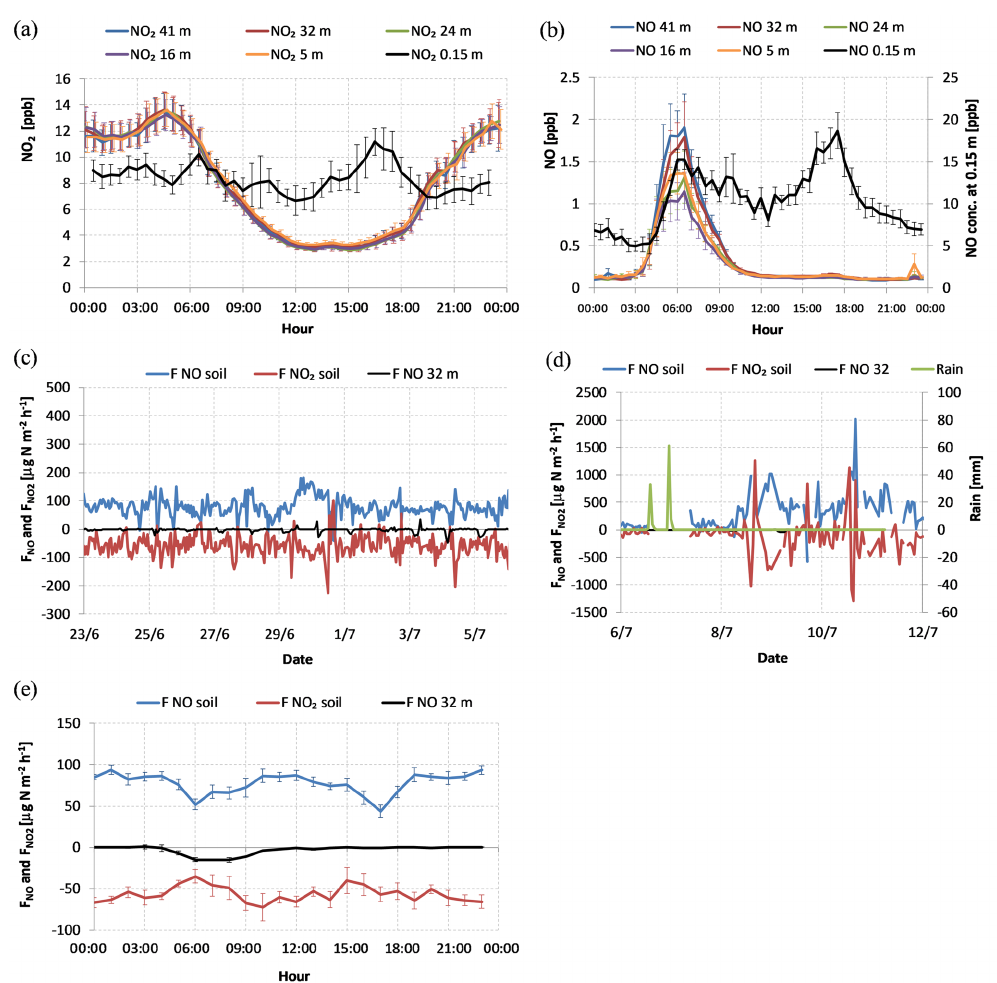
Figure 7. Fluxes and concentrations of NO and NO 2 . (a) Average diel course of NO 2 concentrations at the five levels (41, 32, 24, 16 and 5m); (b) average diel course of NO concentrations; (c) soil NO and NO 2 fluxes and NO fluxes at 32m before rainfall events; (d) soil NO and NO 2 fluxes and NO fluxes at 32m after rainfall events (green line); (e) average diel course of soil NO and NO 2 fluxes and of NO fluxes at 32m. Please note the different scale between (c) and (d) . Vertical bars in (a) , (b) and (e) represent the standard error of the